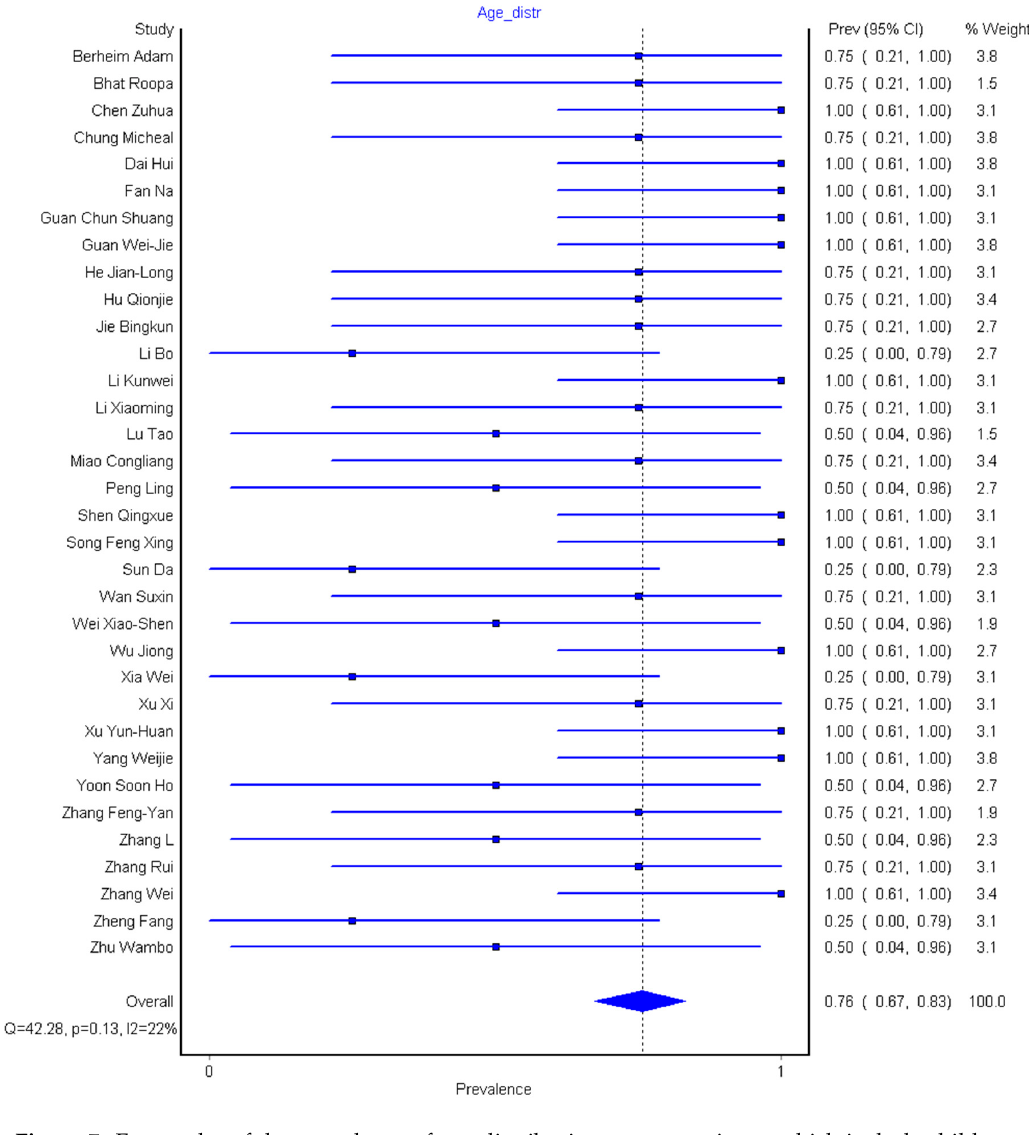
youth, adults, and Figure 7. Forest plot of the prevalence of age distribution among patients, which include children, youth, adults, and elderly.